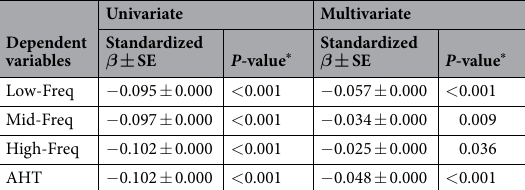
Table 3. Linear regression analyses of hearing thresholds according to potassium intake levels. * The independent variable was potassium intake level, and the multivariate analysis was adjusted for age, sex, diabetes mellitus, hypertension, household income, smoking habits, alcohol intake, education level, physical activity, eGFR, calorie intake, protein intake, fat intake, carbohydrate intake, sodium intake, occupational noise, explosive noise exposure, vitamin A intake, carotene intake, retinol intake, thiamine intake, riboflavin intake, niacin intake, vitamin C intake, and serum vitamin D levels. Abbreviation: AHT, average hearing threshold; Low-Freq, low frequency threshold; Mid-Freq, middle frequency threshold; High-Freq, high frequency threshold; SE, standard error; eGFR, estimated glomerular filtration